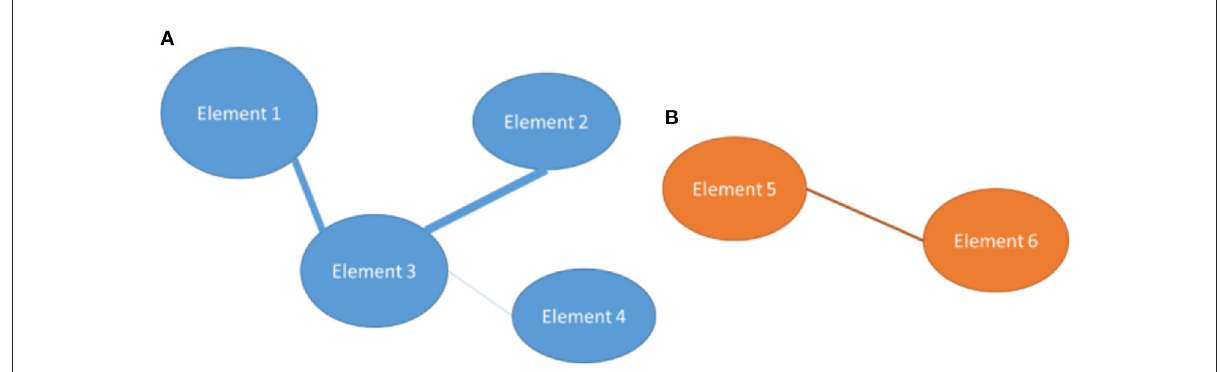
FIGURE2 Thematic network where the different elements (dimensions) and segmentation of the network are linked using a different color for groups, group (A) and group (B) .